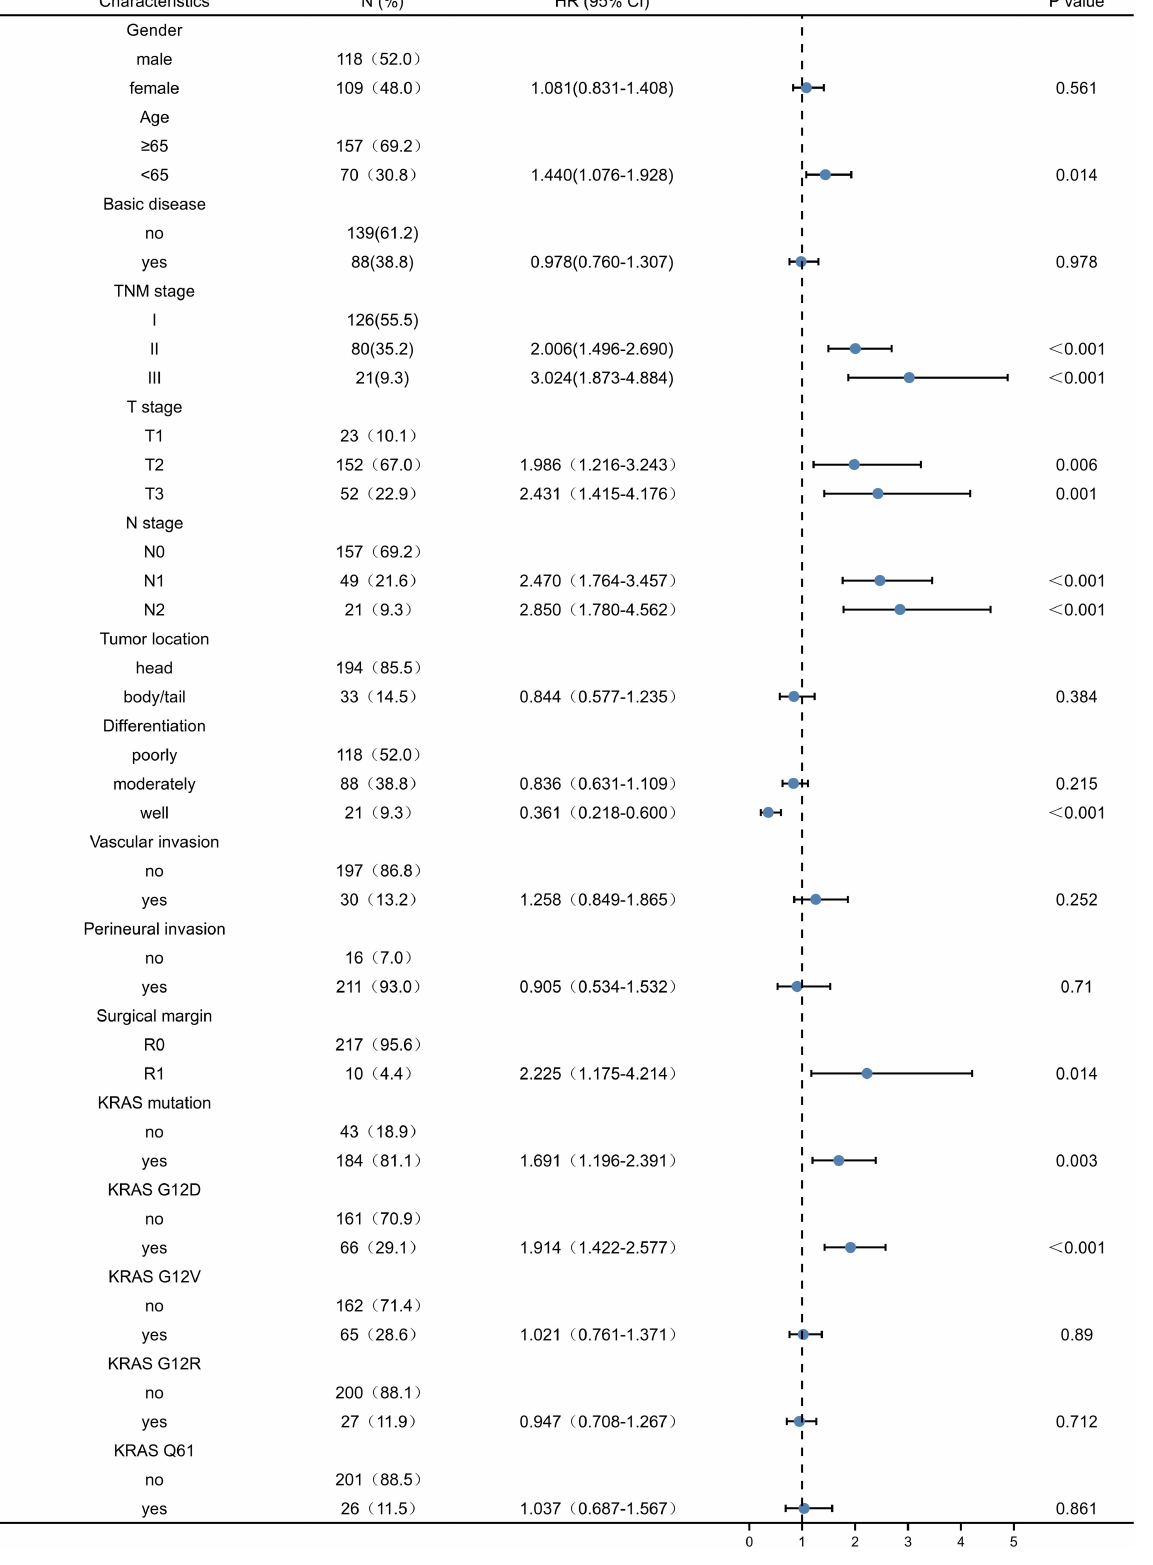
TABLE 3 Univariate analysis of factors affecting patients ’ disease-free survival in pancreatic ductal